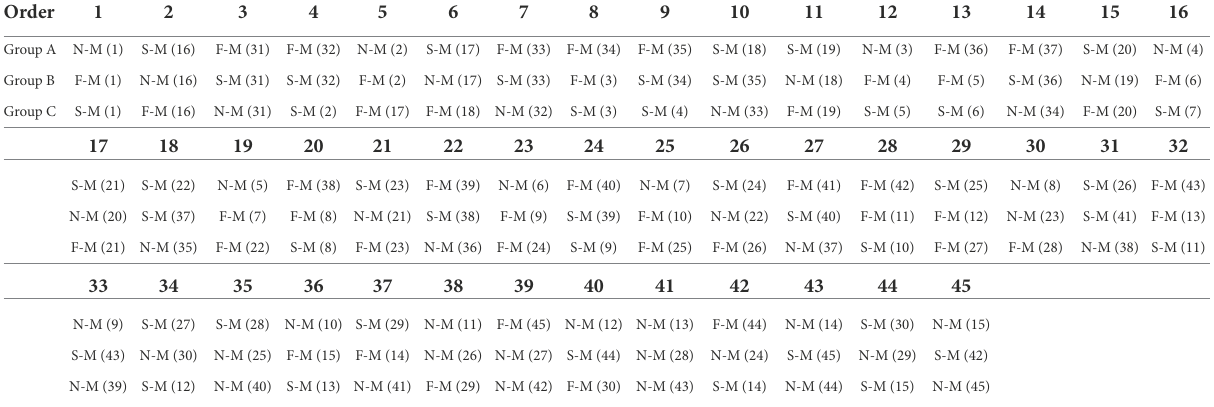
TABLE 1 The sequence of the counter-balanced stimulus presentation.